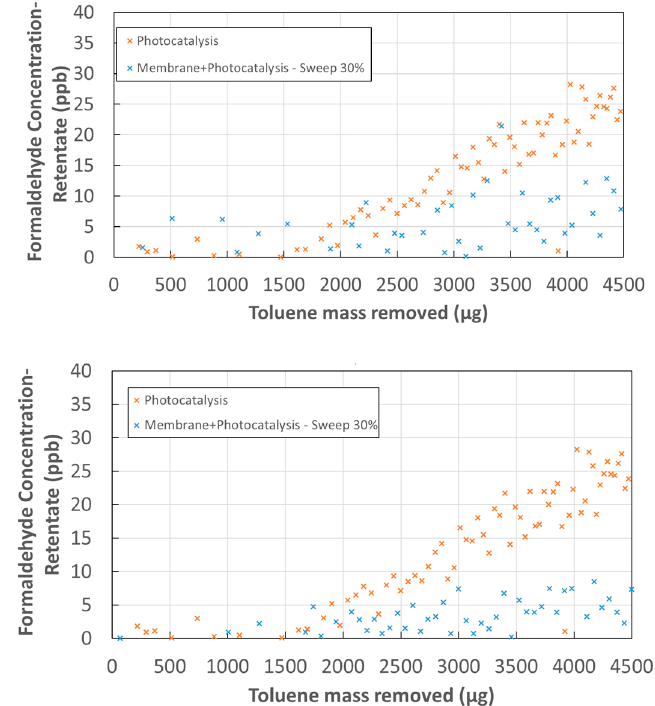
Figure 9. Evolution of formaldehyde concentration in the retentate flow vs. toluene mass removed—PDMS membrane—catalyst m 2 — Sweep gas = 30% − I abs = 6.9 W m − 2 .